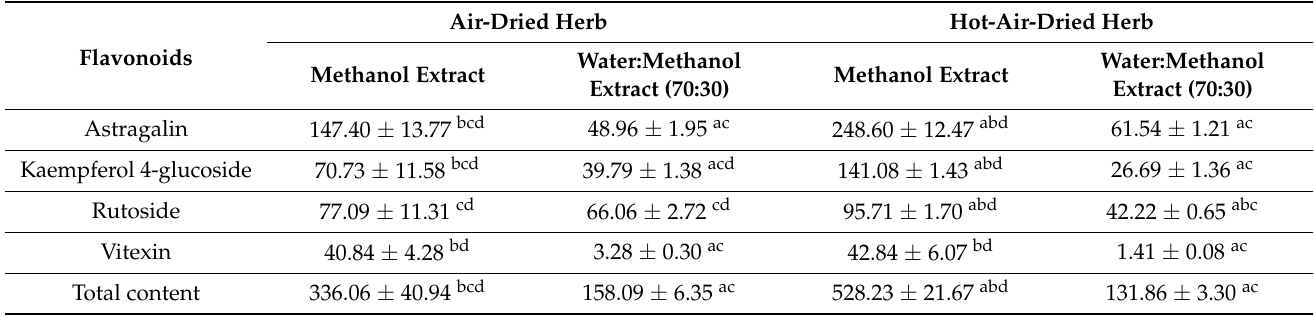
Table 1. Content (mg/100 g DW ± SD) of flavonoids in methanol and water–methanol (70:30) extracts of B. officinalis herb.